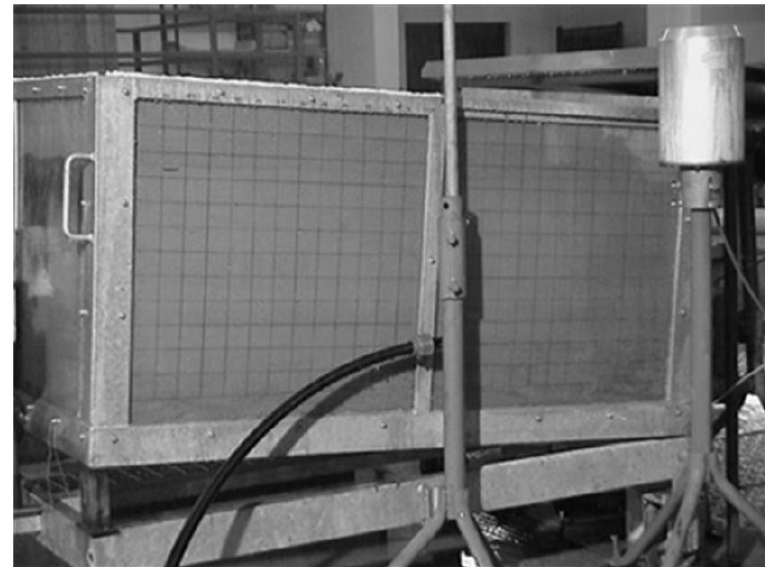
Figure 5. A view of the physical model adopted in the laboratory experiments for slope-infiltration studies.